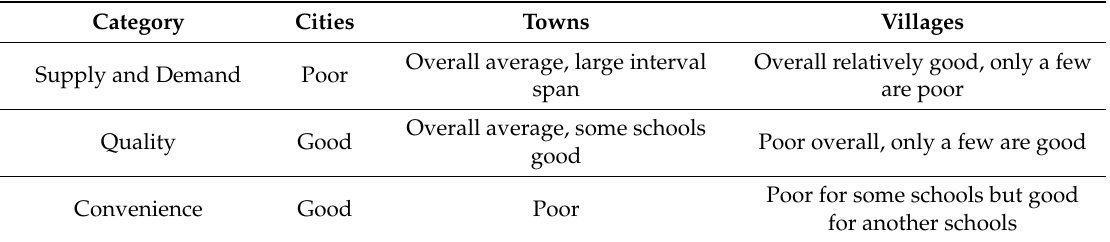
Table 4. The summary of evaluation